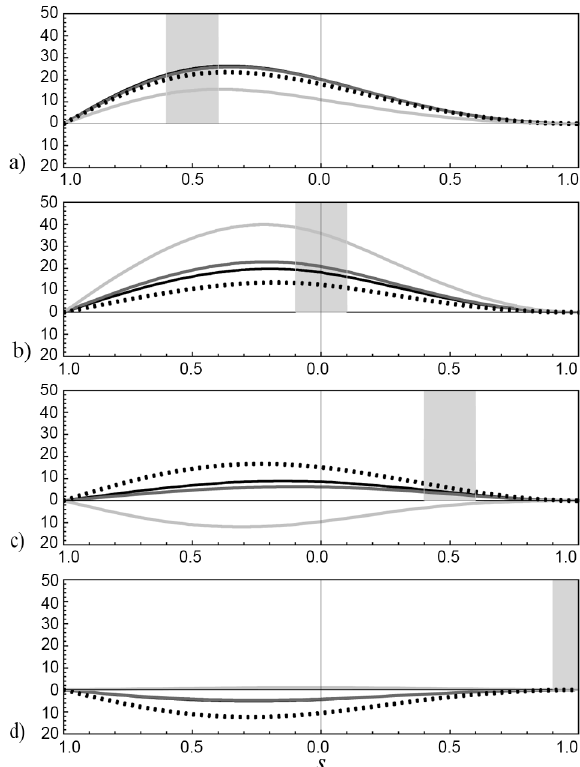
w s τ at instants s 0.5 : a) 1